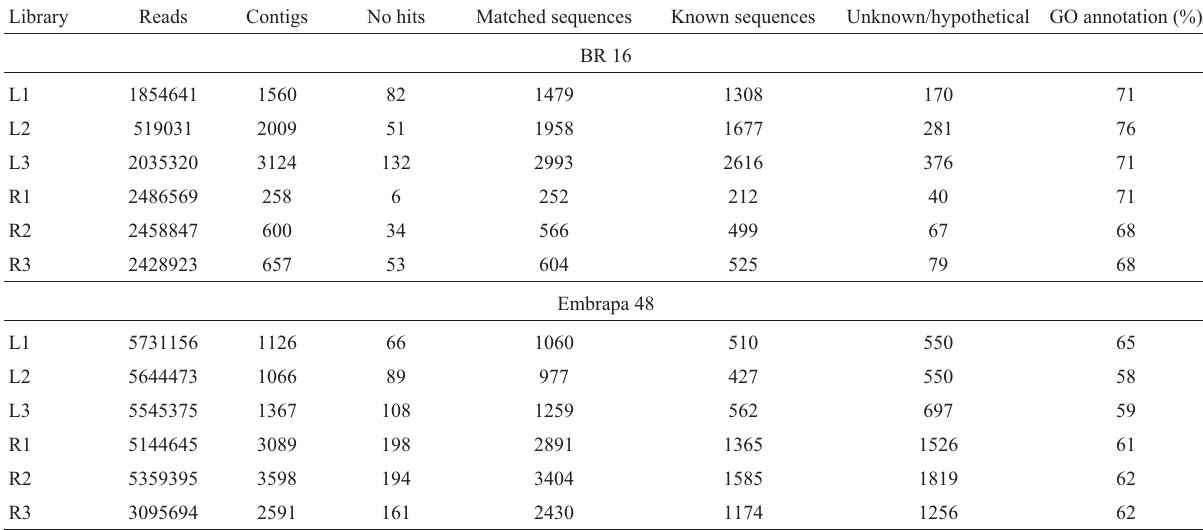
Table 1 - Summary of the total reads sequenced and number of sequences assembled and mapped in each library. (A) BR 16 was sequenced by using a 36bpsinglereadinGenomeAnalyzer lle whereastherunof(B)Embrapa48cultivarwascarriedoutthrougha76bpsinglereadinthesequencerGenome Analyzer llz